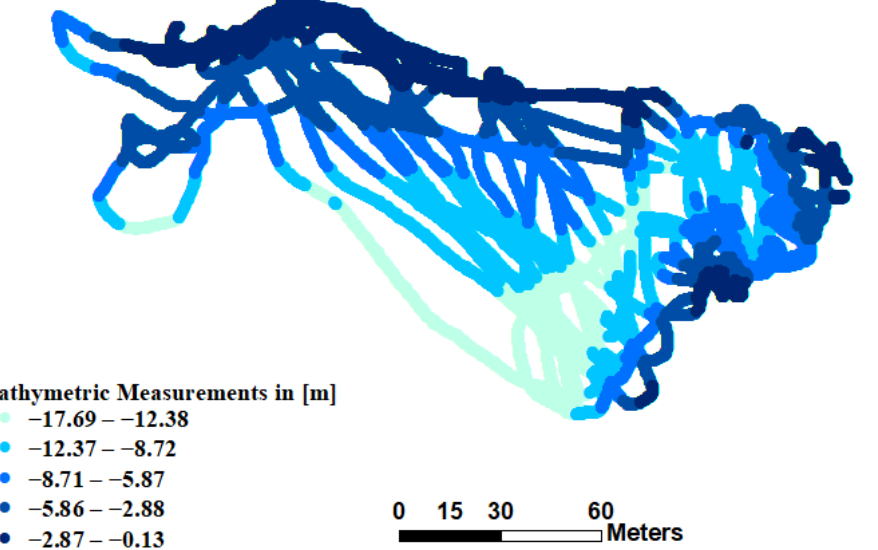
Figure 10. Bathymetric points measurements with color intensity variation representing the distance with respect to the sensor: lighter color stands for higher depth (lower intensity of refracted acoustic signal) and darker color represent swallow water, where the intensity of acoustic signal refraction is